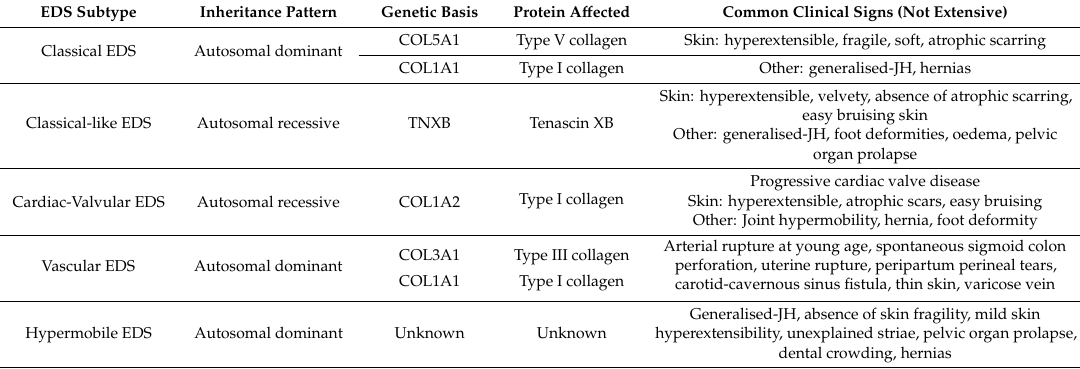
Table 2. Summary of the five most common Ehlers-Danlos Syndrome (EDS) subtypes. Adapted from Malfait et al., 2017 [16].